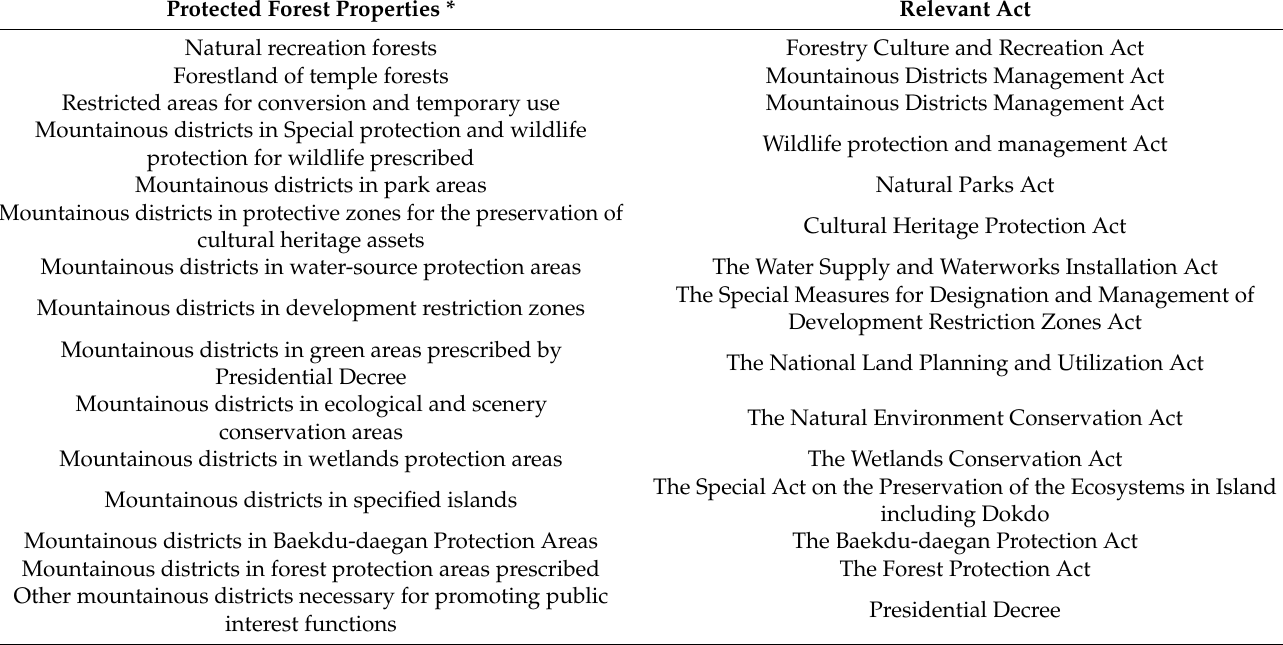
Table A1. Classification of forest lands for public benefit in South Korea